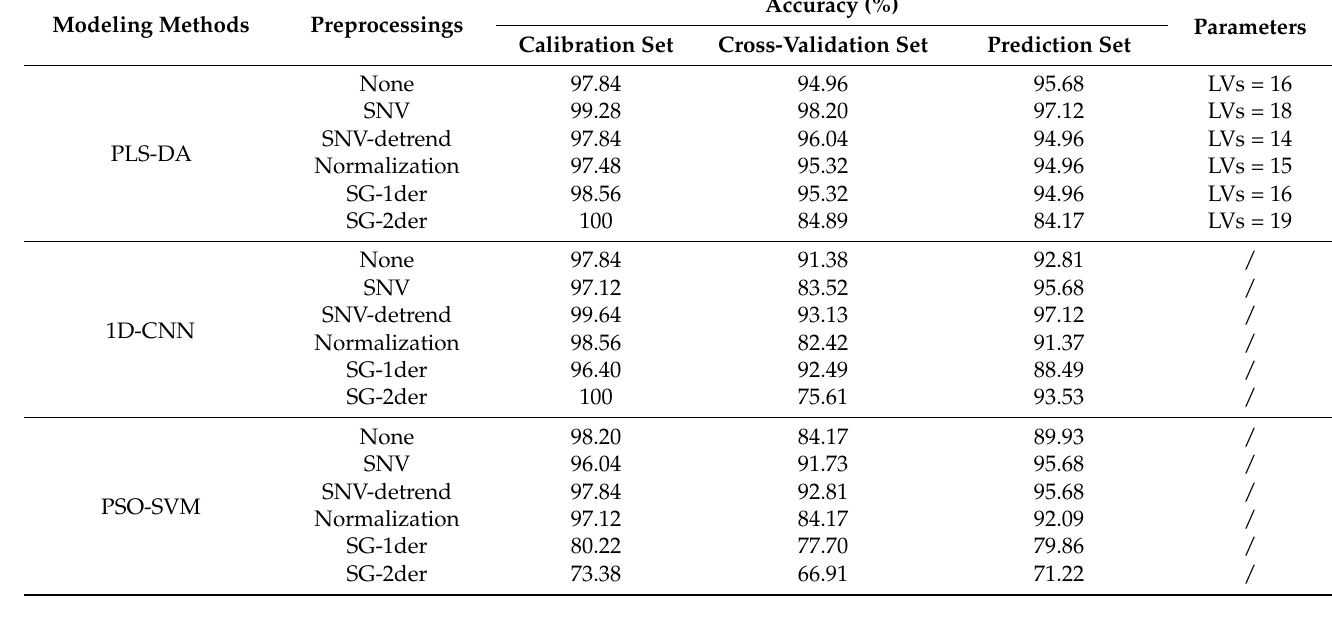
1der and SG-2der). The last column in Table 4 shows the optimal parameters of the model. Figure 6 visualizes the process of finding LVs in the PLS-DA model based on raw spectra. After that, the value of LVs was finalized as 16, because the error rate corresponding to the 16 LVs has been around 0.05, and the improvement of accuracy was not obvious since then. Figure 7 visualizes the accuracy and loss curves of 1D-CNN model based on raw spectra. With the increase of epochs, the accuracy of training set and validation set was increasing, while both losses were decreasing. The curve trend of training set and cross-validation set was the same, and with no overfitting. Table 4. Performance of the classification models based on full wavelengths with or without preprocessings. Modeling Methods